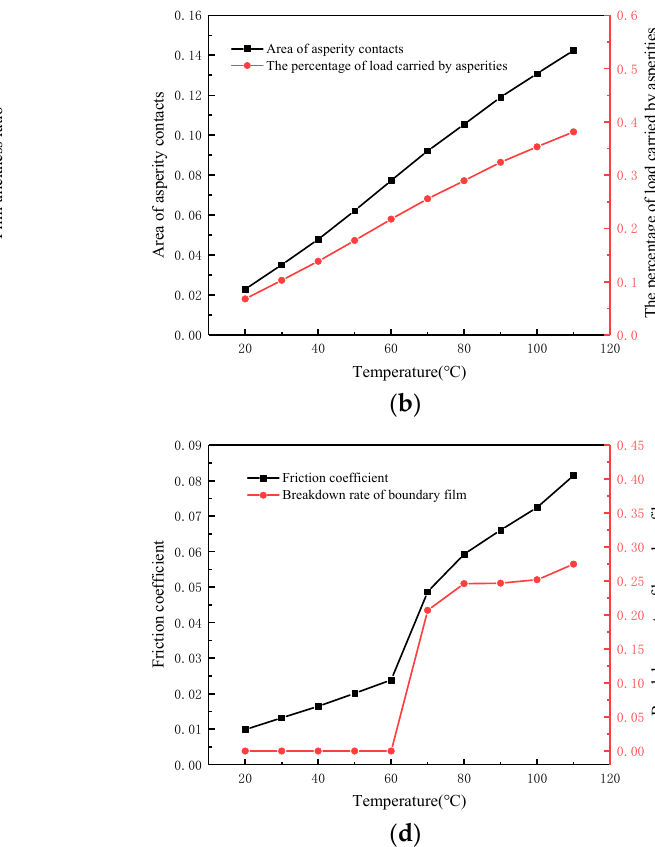
Figure 18. Influence of temperature on lubrication performance. ( a ) Calculated film thickness; ( b ) Calculated asperity contacts; ( c ) Calculated friction components; ( d ) Calculated friction coefficient.